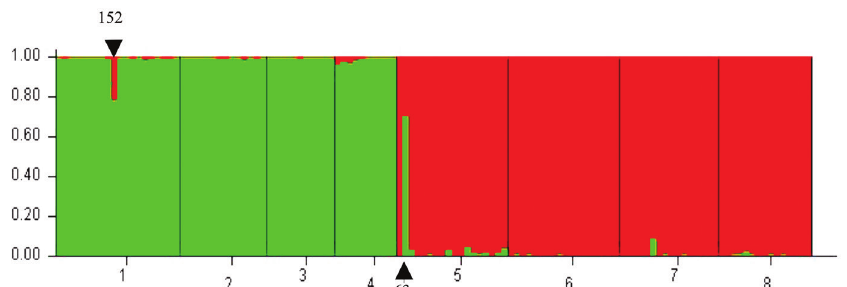
Fig. 2. Structure bar plots of probabilities of assignment of each individual from populations of CP in green (1 - TOC, 2 - ITU, 3 - ML and 4 - FU) and CK in red (5 - TOC, 6 - ITU, 7 - TRM, 8 - RD). Probabilities of assignment (q) of each individual to each cluster are shown along the